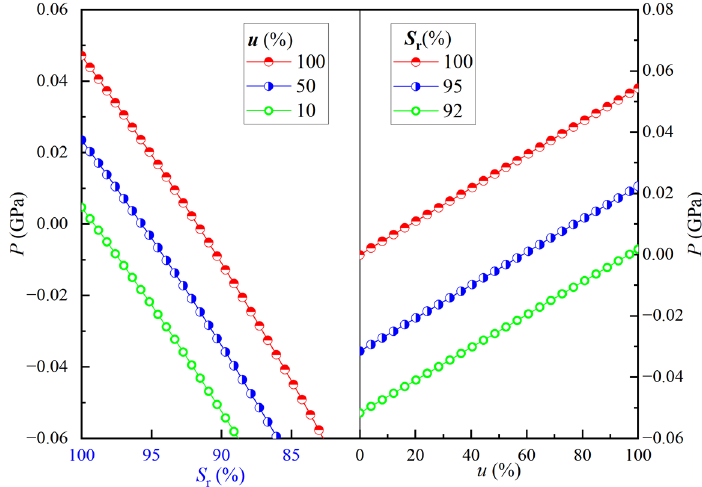
Figure 12. Frost heaving force versus saturation and freezing rates. Dynamic Elastic